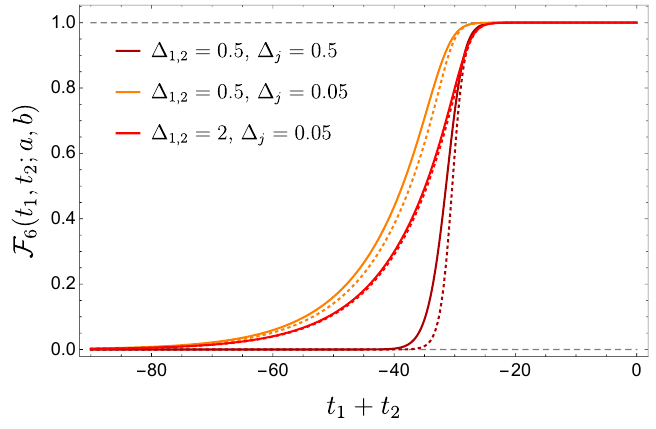
Figure 3 . Plot of F 6 ( t 1 , t 2 ; a, b ) for a, b (cid:29) − t 1 , 2 . Full lines give the exact result (2.9) for the eikonal integral. Dotted lines correspond to the ‘heavy-heavy-light’ saddle point approximation (2.4), which also coincides with the geodesic approximation in JT gravity. The saddle point approximation gets better as the ratio ∆ ∆ increases. The characteristic timescale for exponential decay is 1 , 2 / j − ( t 1 + t 2 ) ∼ 2 t ∗ . We set G/ (2 sin δ 1 , 2 ) = 10 − 6 (such that 2 t ∗ ≈ 28